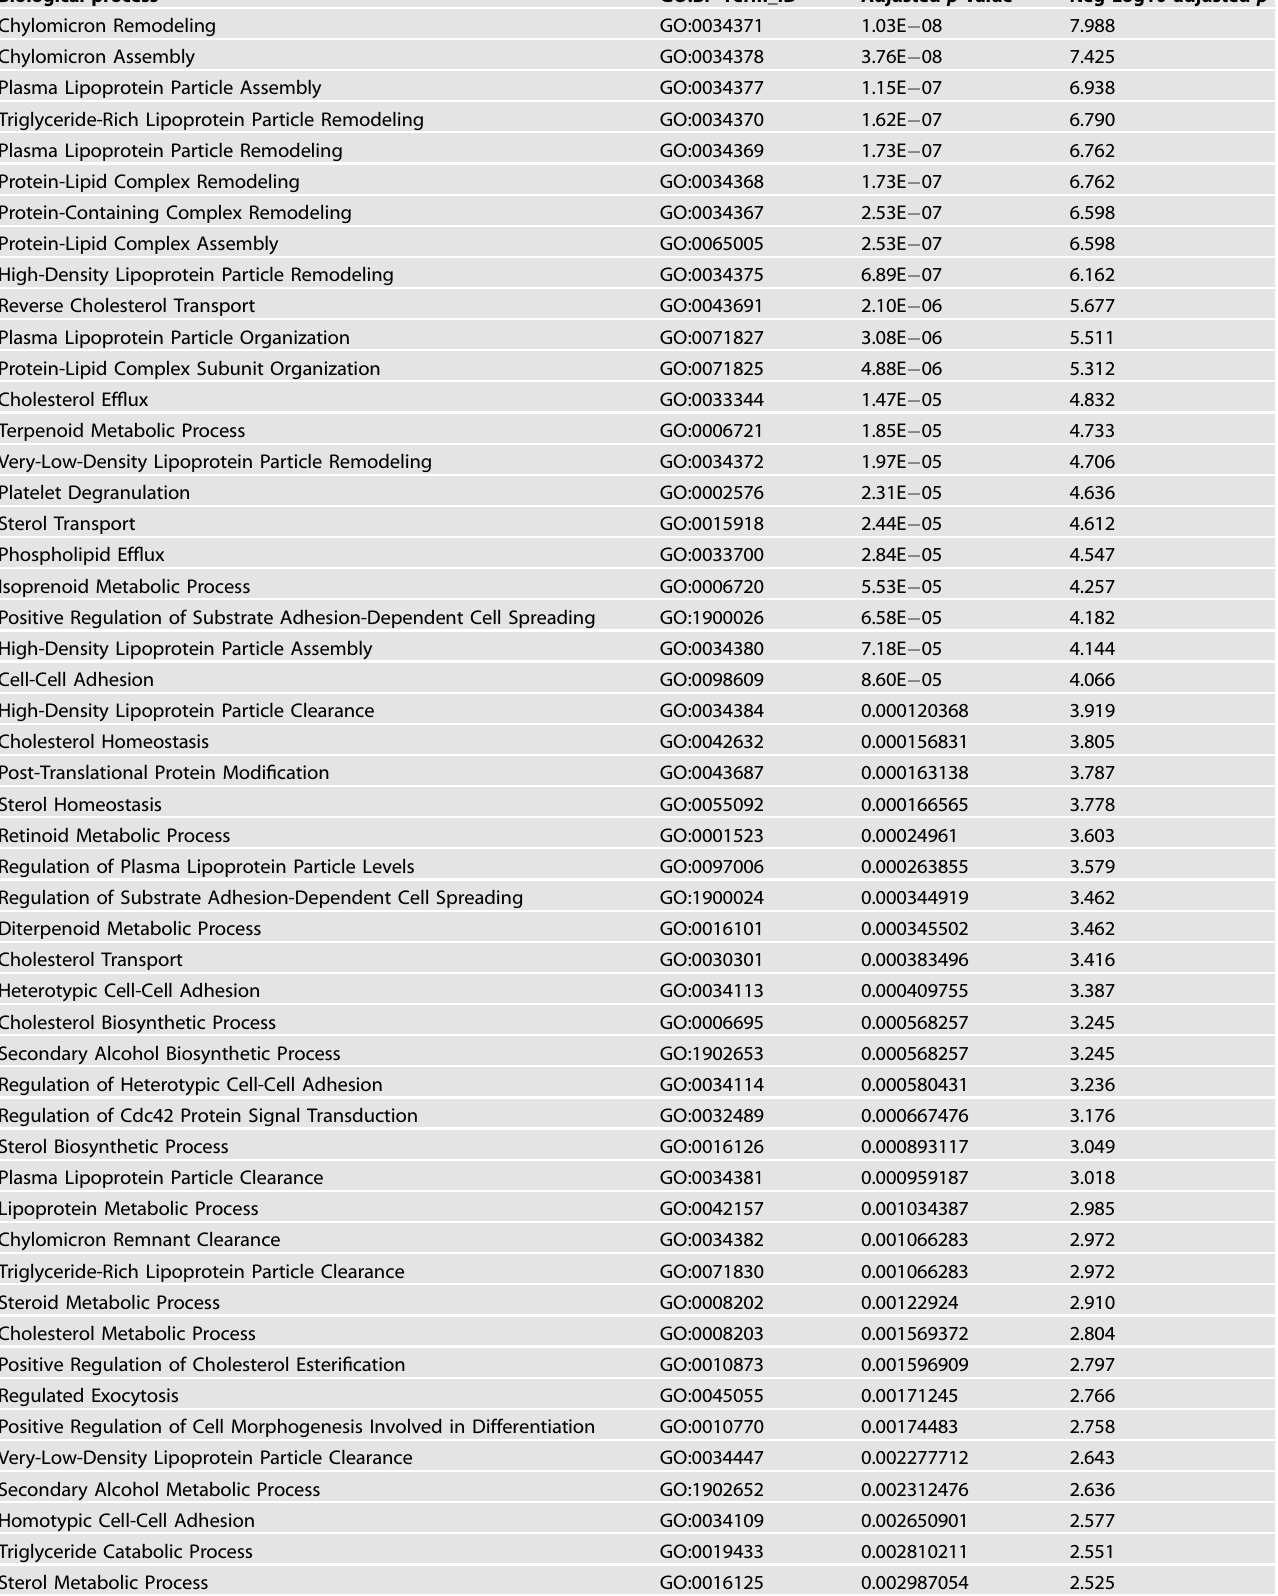
Table 4. Up-regulated GO biological processes in Scz organoids ( p <